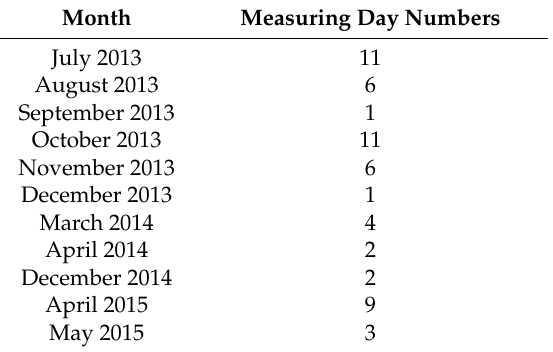
Month Measuring Day